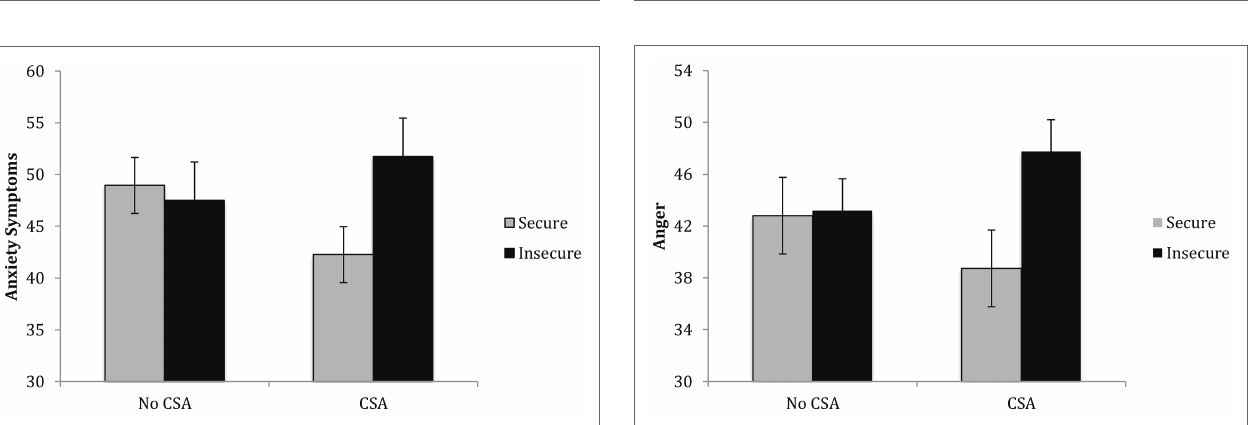
FIGURE 3 | Children’s CSA history and attachment interact in predicting their depression symptoms.